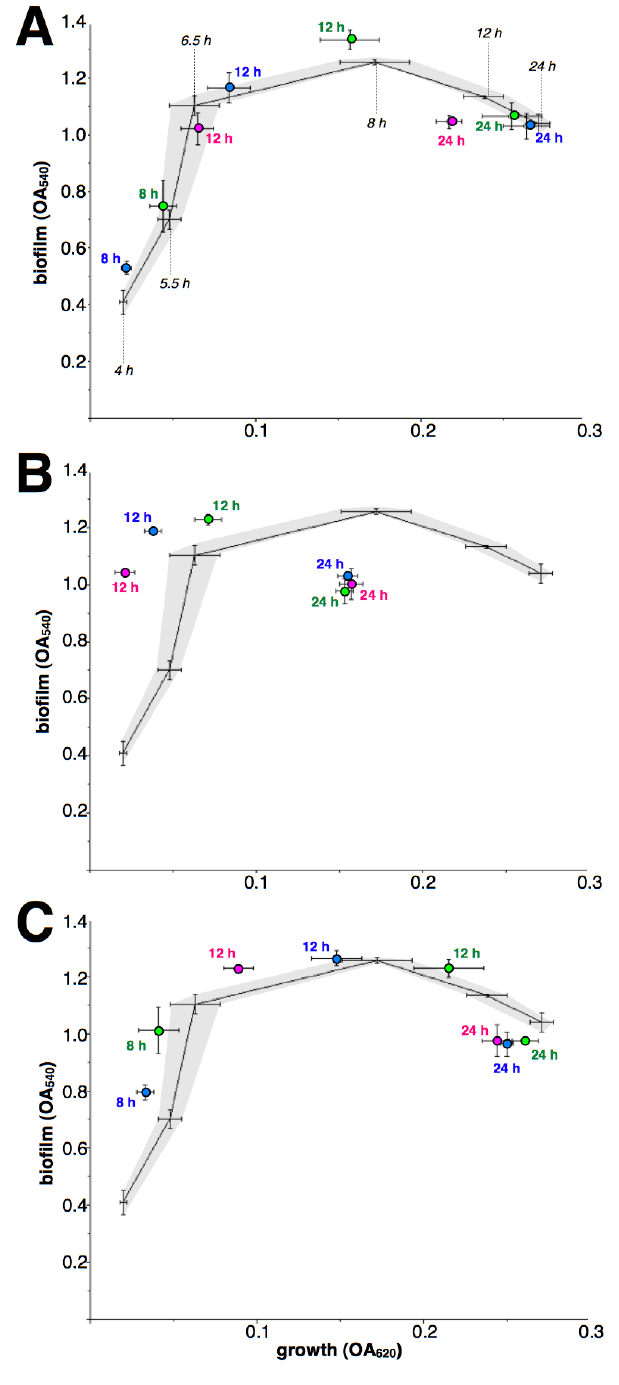
Figure 3. Effect of macrolides upon biofilm formation by S. aureus strain i1 (inducible MLS B ). Lines (means of four independent experiments) and dashed areas (defined by standard deviations of each point) show the relationship growth/biofilm formation (as OA at 620 and 540 nm, respectively) in the absence of antibiotics at 4, 5.5, 6.5, 8, 12 and 24 h (indicated with black italics only in the top figure). The effect of ERY ( A ), CLA ( B ) and AZI ( C ) at 8, 12 and 24 h is shown as circles (means with standard deviations of four independent experiments), green for 0.5 µg/mL, blue for 1 µg/mL and magenta for 2 µg/mL; close to each symbol, numbers indicate incubation time. Missing data was caused by non-detectable growth (ERY 2/8, CLA 0.5/8, CLA 1/8, CLA 2/8 and AZI 2/8).